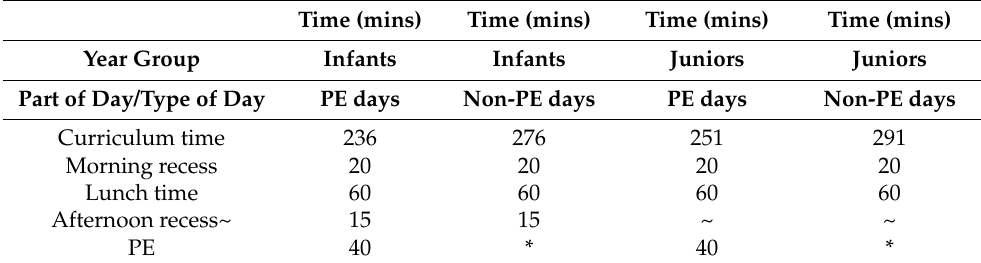
Table 1. Total number of minutes of for each part of the school day according to type of day and age